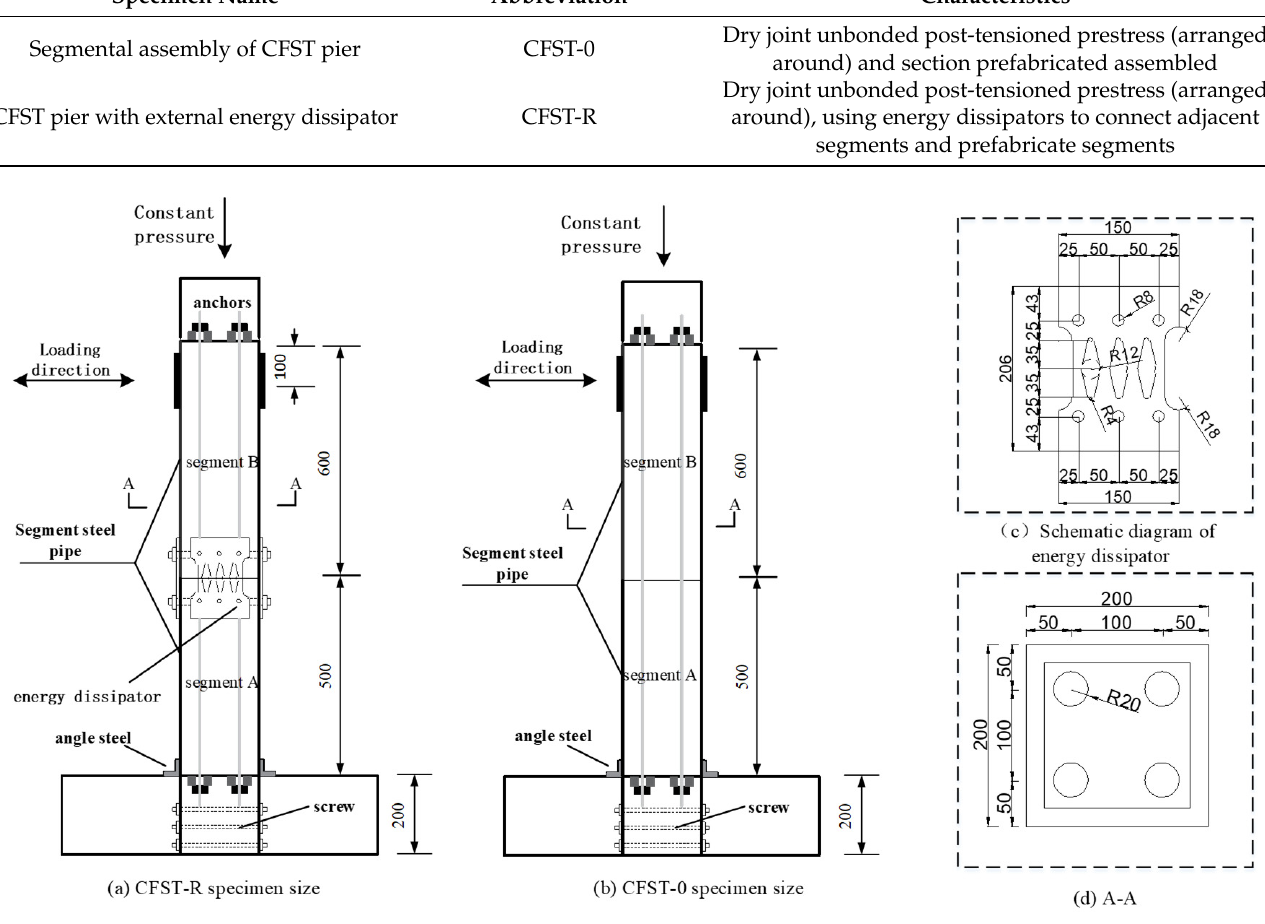
Figure 5. Section prefabricated assembled CFST bridge pier model specimen structure.